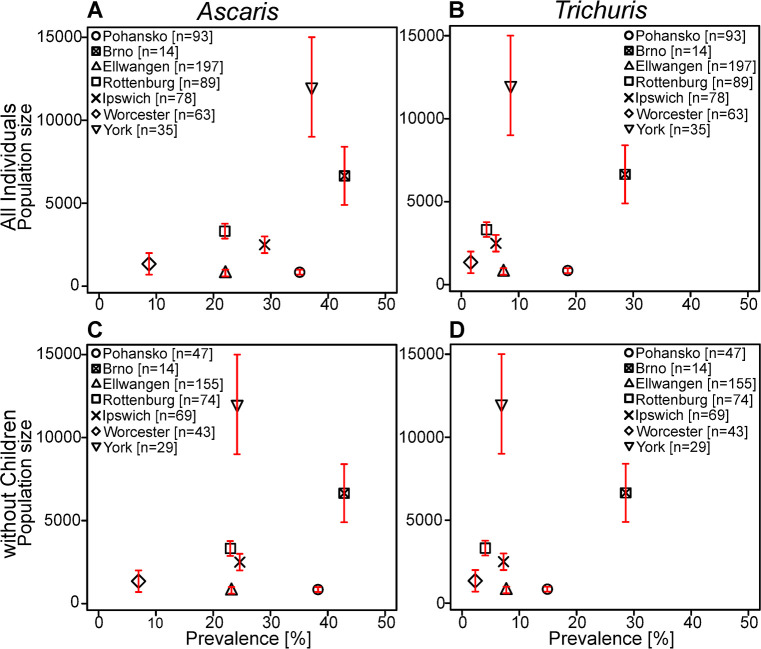
The influence of population size on parasite prevalence.The population size of the different locations was estimated from historical records and plotted against the prevalence of Ascaris (A and C) or Trichuris (B and D). Panels A and C represent the whole data set. Panels B and D represent data from adult groups (>18 years or identified as adult). Each site is identified with a different symbol according to the insert. The numbers of samples considered with each site are given in the insert. The error bars represent the range of estimated population size for each group.